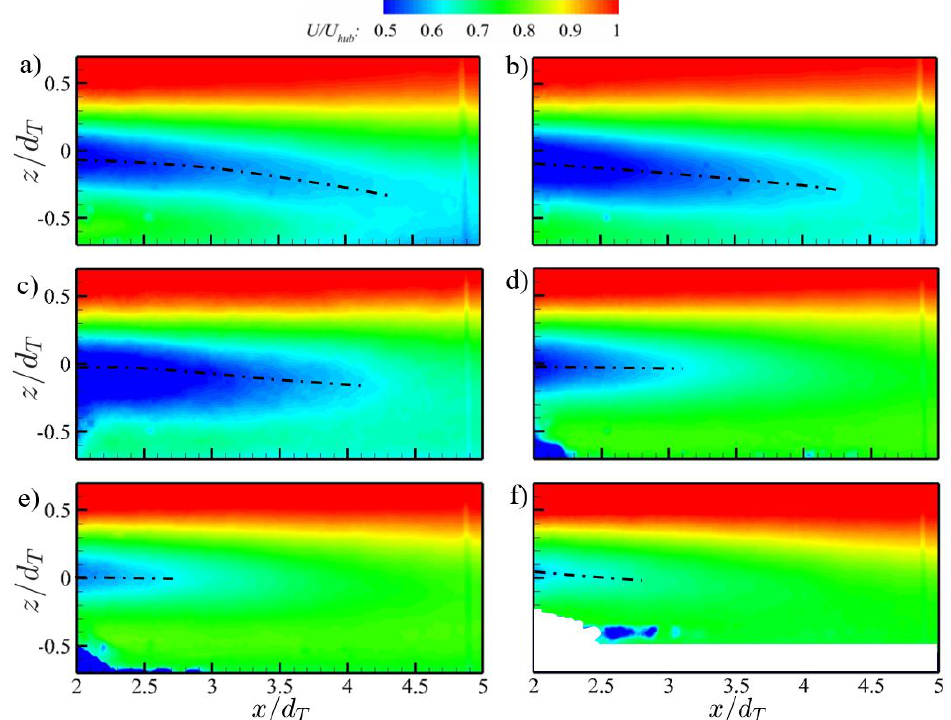
Figure 3. Mean velocity distributions, U / U hub ( x / d T , z / d T ) , in the center plane ( y = 0) for the backward- and forward-facing step cases and flat terrain with ∆ z 0 / d T equal to: ( a ) − 0.64; ( b ) − 0.42;